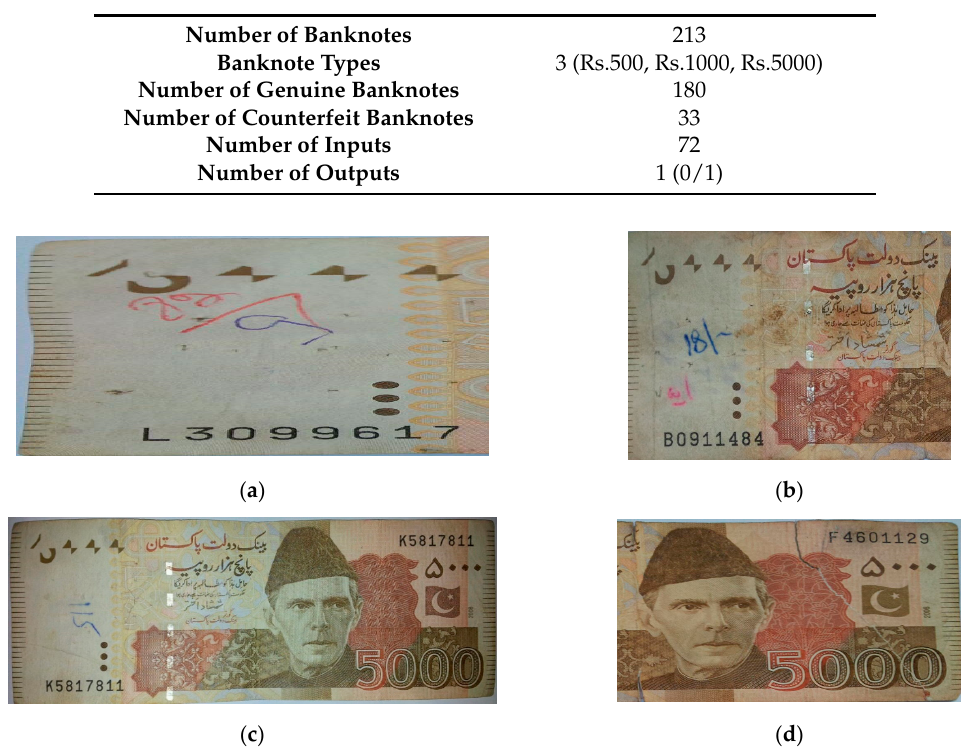
Table 5. Support Vector Machines (SVMs) learning parameters.